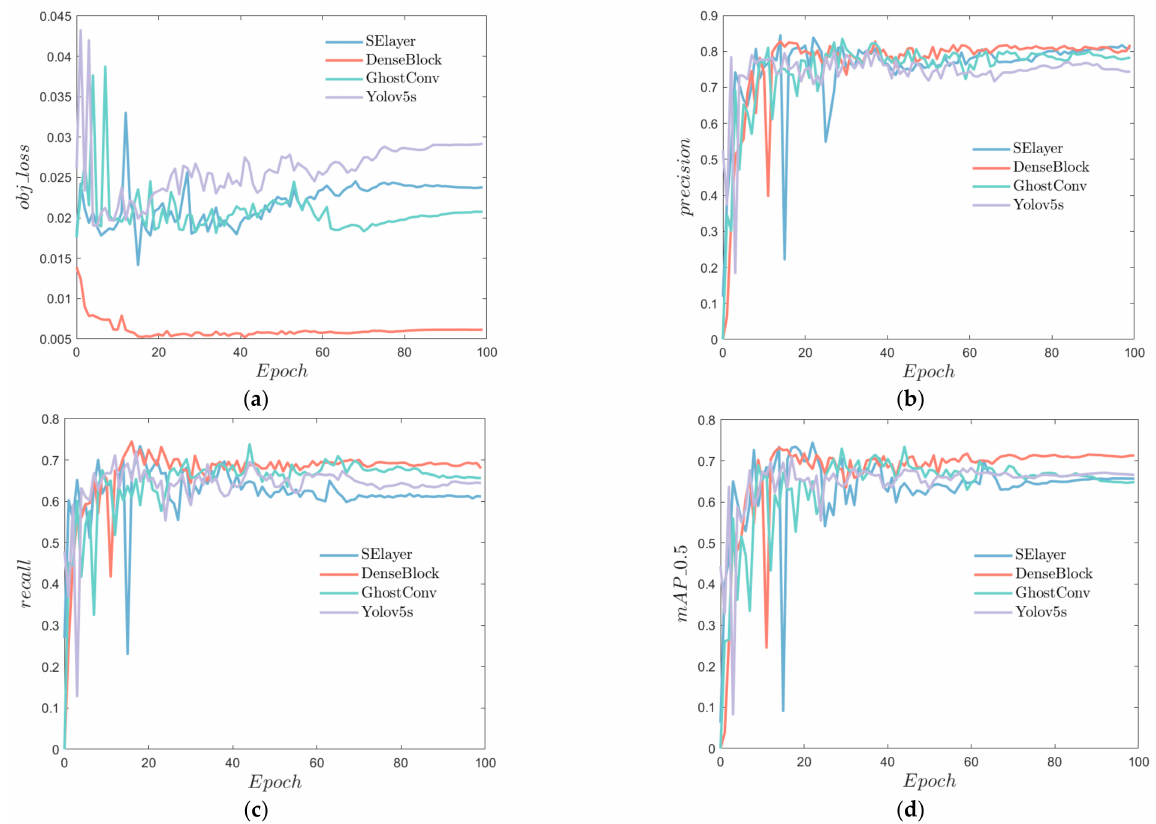
Figure 19. Comparison of results of single-module training. ( a ) Target loss. ( b ) Accuracy rate. ( c ) Recalling rate. ( d ) mAP